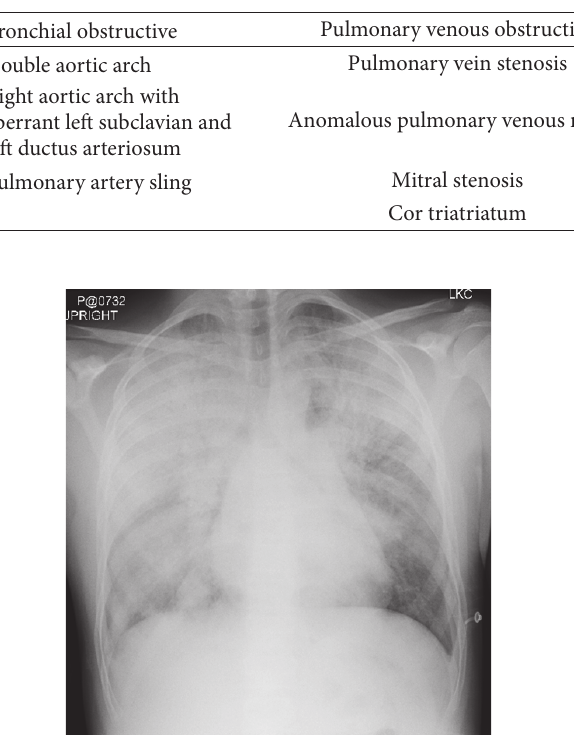
Figure 1: Chest X-ray at presentation demonstrating extensive airspacediseasethatwasinterpretedasmultifocalpneumoniaversus pulmonary